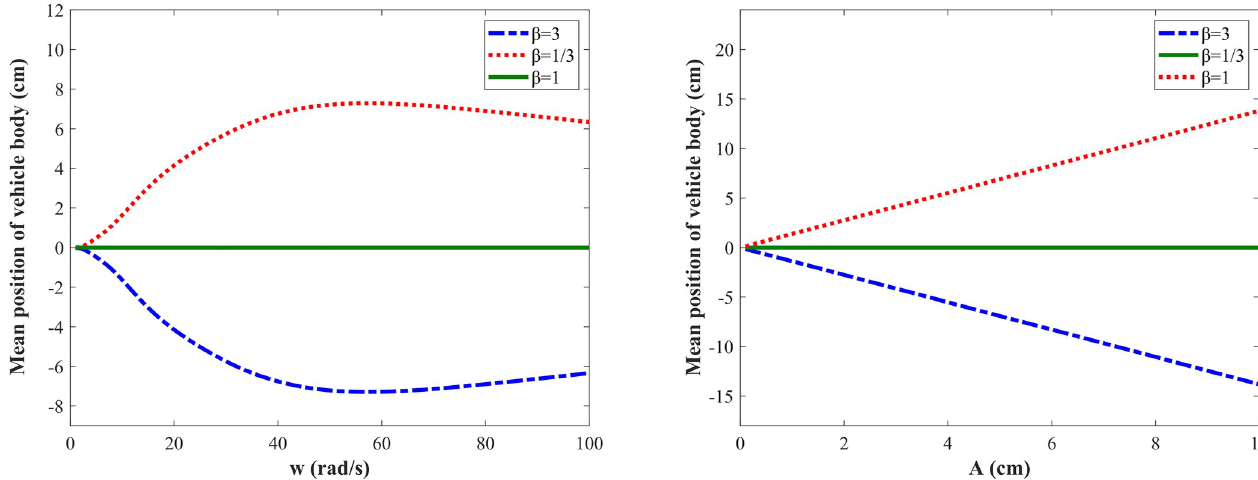
Fig 5. Mean position response of vehicle body under different road excitation. (A) Varying road frequencies; (B) Varying road amplitudes.